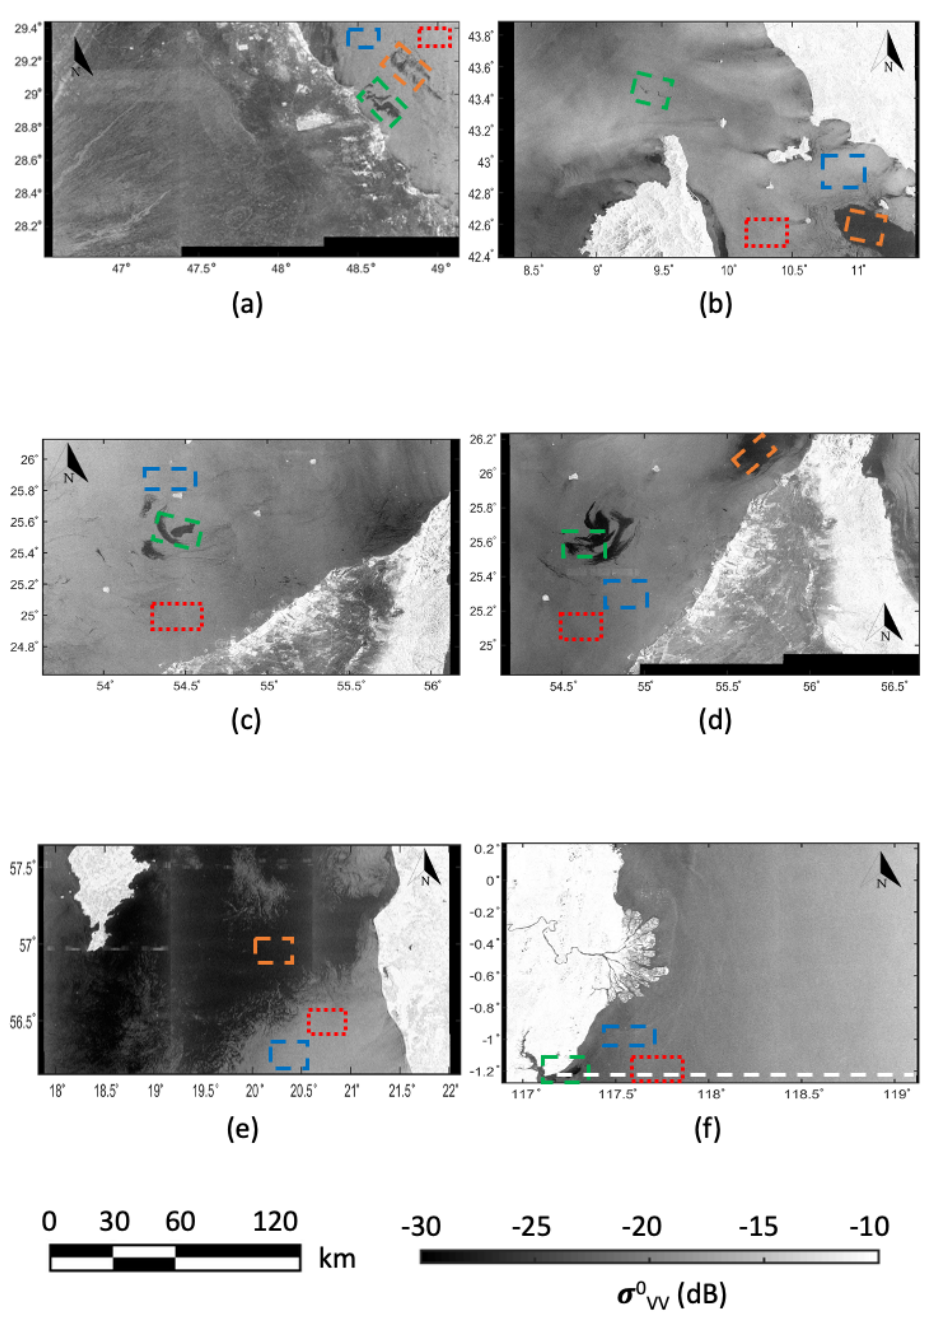
Figure 2. S1 synthetic aperture radar (SAR) dataset: VV-polarized normalized radar cross section (NRCS) graytones images (in dB scale) that include low-backscattering areas. ( a – f ) refer to the SAR scenes labeled as data ID 1–6 in Table 1. The regions of interest (ROIs) that refer to slick-free sea surface, oil slick, and look-alike are highlighted with blue-, green-, and orange-dashed boxes, respectively. An extra slick-free sea surface ROI, highlighted with a dashed red box, is also considered to analyze the intrinsic sea surface